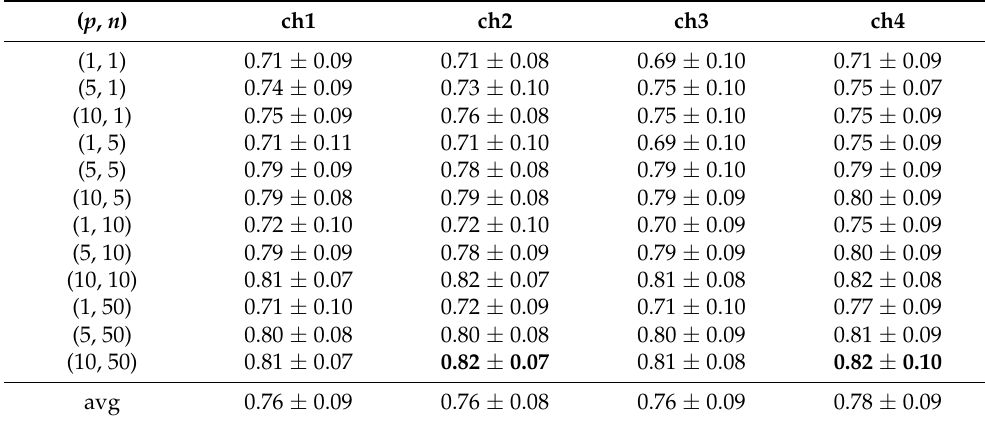
Table 5. A3S-Rec dataset: AUPRC of the 10-way 10-shot SWC prototypical model, considering internal labeling for the recordings of channels 1-2-3-4.